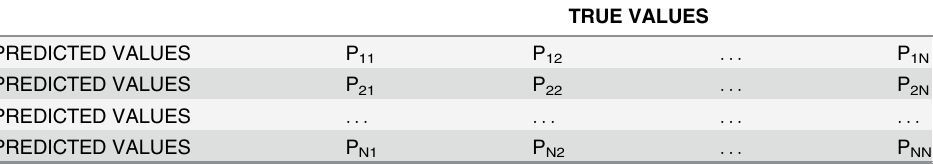
Table 1. Confusion matrix.